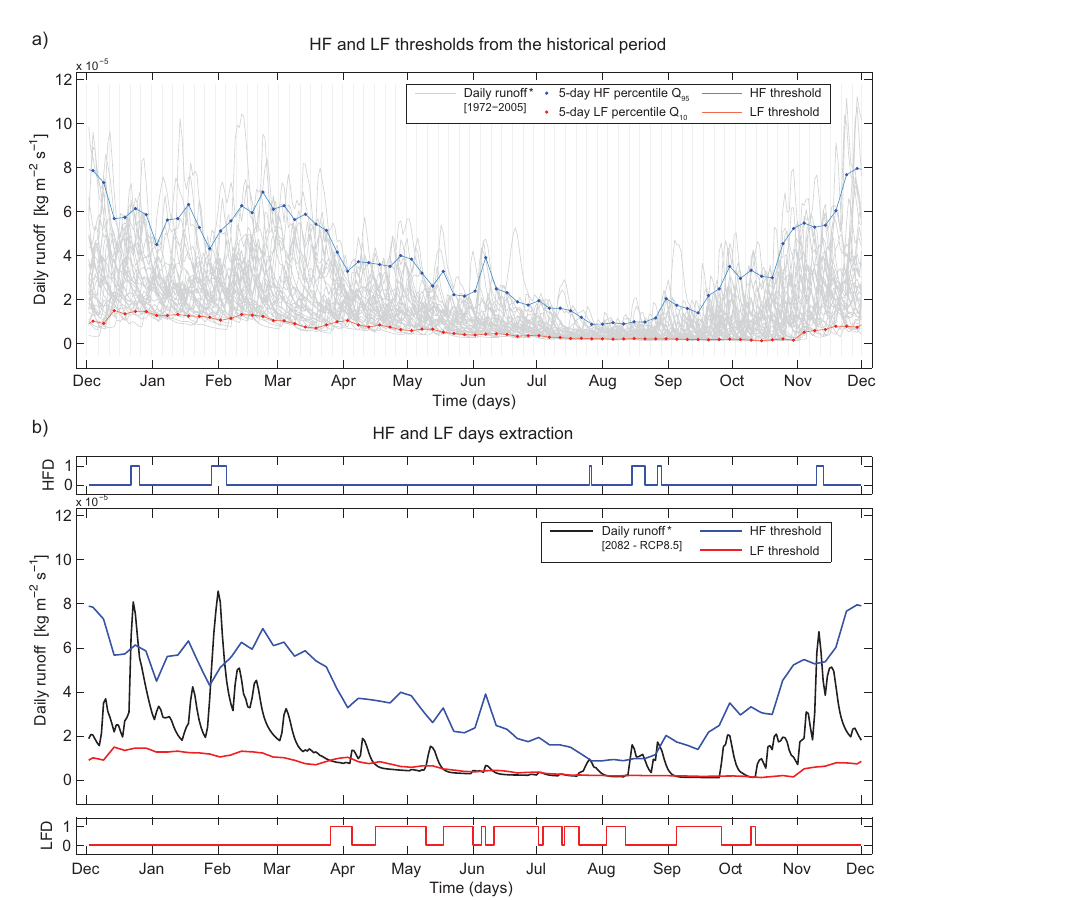
Figure B1. Schematic of HFD and LFD extraction (days under high and low flows): (a) daily varying threshold curves for HF and LF from 5-day percentiles calculated over the historical period; (b) High and low flow days extraction for a given year. For this figure we used runs of a southern European grid cell (lat 43.75 ◦ N, long 11.25 ◦ E) from (a) historical (Dec 1971 to Dec 2005) and (b) RCP8.5 (2082) periods of the